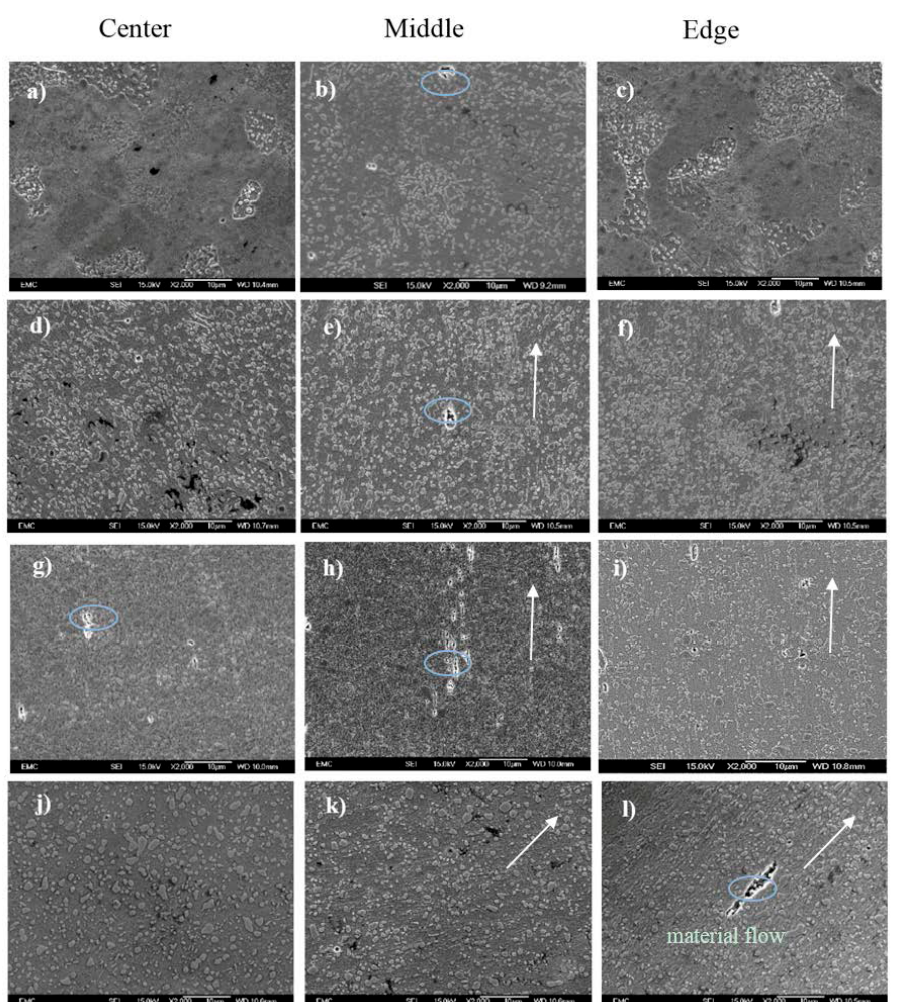
Figure 10. SEM showing the microstructure ( a – c ) at the disc center, middle and edge area in the annealed state and ( d – f ) after HPT processing at 3 GPa pressure with number of rotation of 1 turn, ( g – i ) 2 turns and ( j – l ) 3 turns. (The arrow indicates the shear orientation, the blue circle indicates the hole).